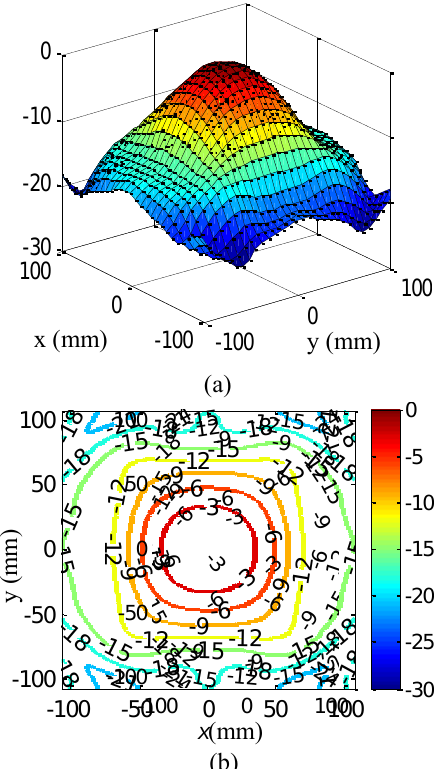
Figure 9: (a) A 3-D plot of the simulated normalized power density of 13 × 13 dual-focused transmitarray. (b) A contour plot of the simulated normalized power density of for the dual-focused transmitarray in x-y plane at R o = 310 mm.